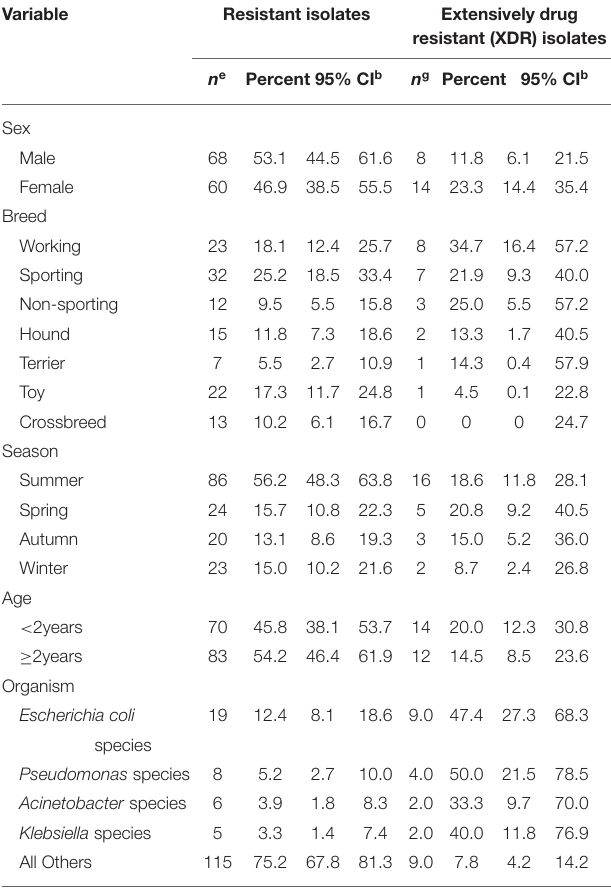
b Confidence interval. e Number of resistant isolates. g Number of multidrug resistant